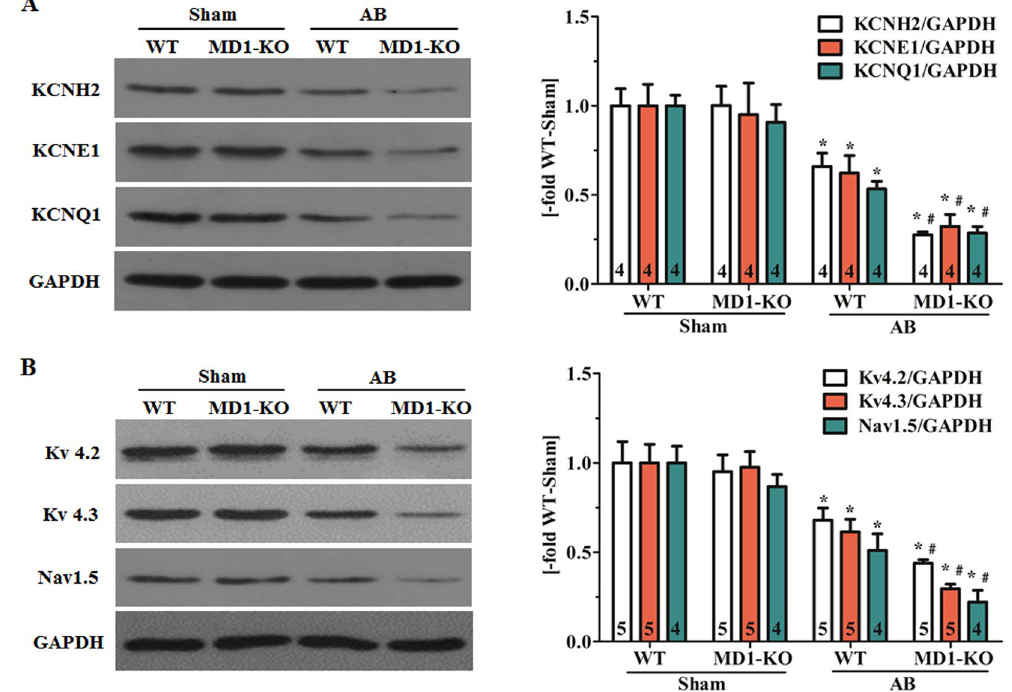
Figure 6. MD1 regulates the expression of K + and Na + channels in failing hearts. Immunoblot analysis of WT and MD1-KO left-ventricle samples at 4 weeks after surgery for ( A ) KCNH2, KCNE1 and KCNQ1 expression; ( B ) Kv4.2, Kv4.3 and Nav1.5 expression. Left: representative original immunoblots; right: quantitative results. Data were normalized to GAPDH. Numbers of mice per group are shown inside bars. * P < 0.02 vs. WT-Sham, # P < 0.05 vs.